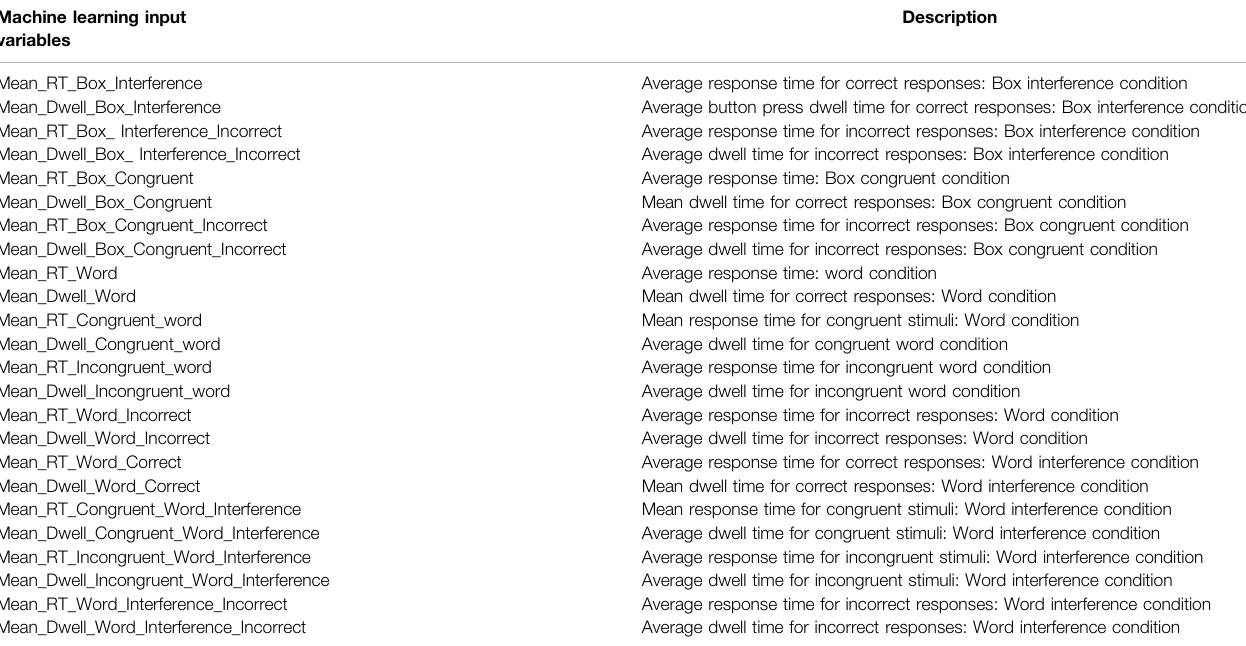
TABLE 1 | Machine learning input variables. Machine learning input